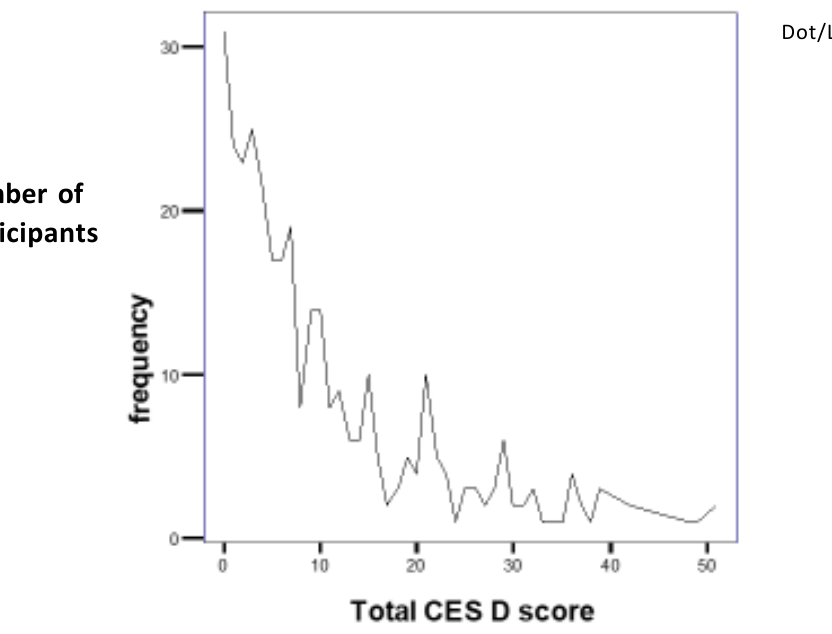
Figure 1. Frequency distribution (in numbers) of total CES D score in the sample (n=335); the cut-off level for clinical depression was a score of ≥≥ ≥≥ ≥